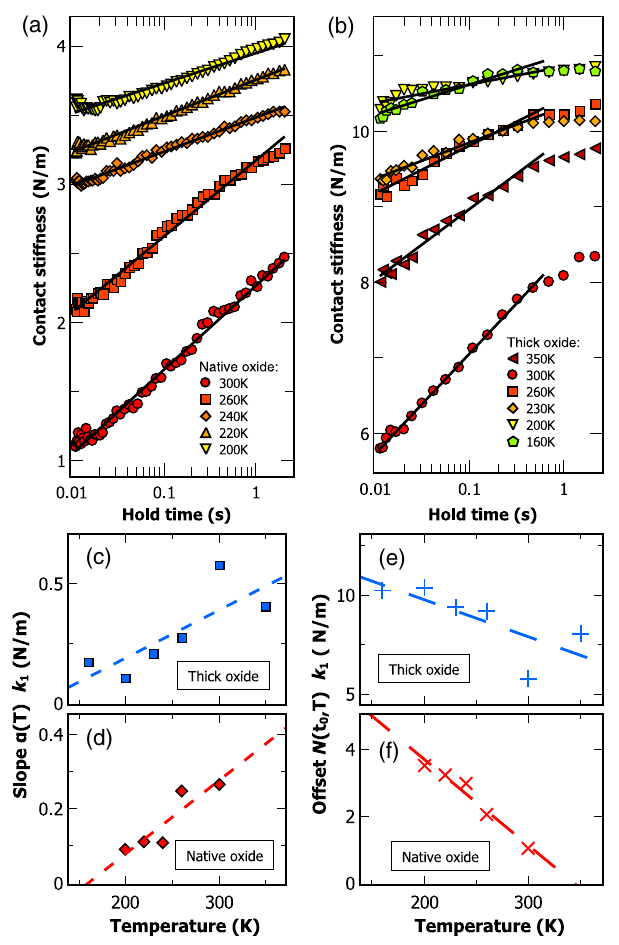
FIG. 2. Characterizing contact aging dynamics by contact stiffness measurements. Contact stiffness as a function of hold time measured for different temperatures on silicon with a native oxide layer (a) and a 300-nm-thick oxide layer (b). The contact stiffness shows logarithmic aging, and fits (solid black lines) for ¼ 0 . 6 s reveal temperature-dependent hold times up to t hold slopes, as shown for the native oxide layer (c) and the 300- nm-thick oxide layer (d). In both cases, the temperature depend- ence of the slopes can be well approximated by a linear function with almost identical slope. (e),(f) Initial contact stiffness at t ¼ 10 ms as a function of the temperature. In both cases, the initial contact stiffness decreases with